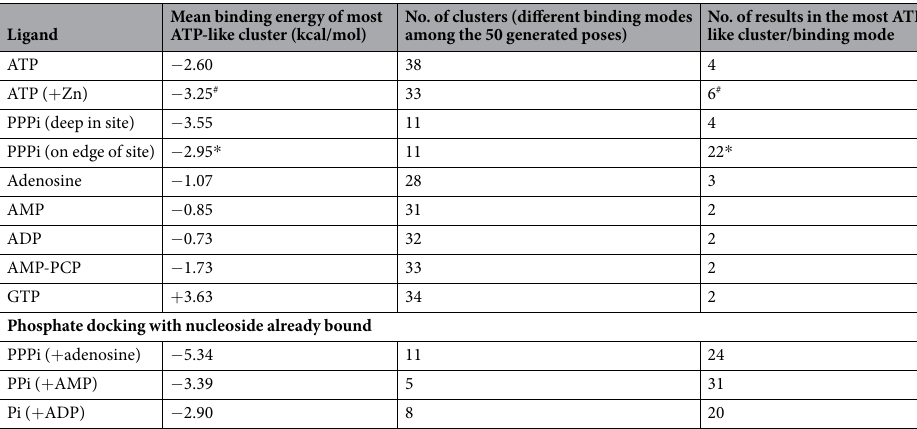
Table 2. Docking scores of ATP-like ligands. Shown are the mean binding energies (kcal/mol) of the most ATP-like cluster of results predicted by Autodock for the various ligands listed (column 2), the total number of clusters (i.e binding modes grouped together by similarity, column 3), and the number of poses that were in the most ATP-like cluster (column 4). The table provides an indication of the extent to which the results predicted by Autodock were similar to the RyR1 ATP-bound des Georges et al . (2016) structure. * PPPi has two different interesting binding modes. The first-mentioned is the lowest-energy one which is fairly deep in the adenine pocket. In the second-mentioned cluster, the triphosphate occupies a position in which it would overlap with the triphosphate of ATP. # For ATP (with Zn 2 + bound to the protein) none of the poses obtained were ‘ATP-like’ when compared with the des Georges et al . (2016) RyR1 ATP-bound RyR1 structure. In this case we therefore report the energy of the lowest energy